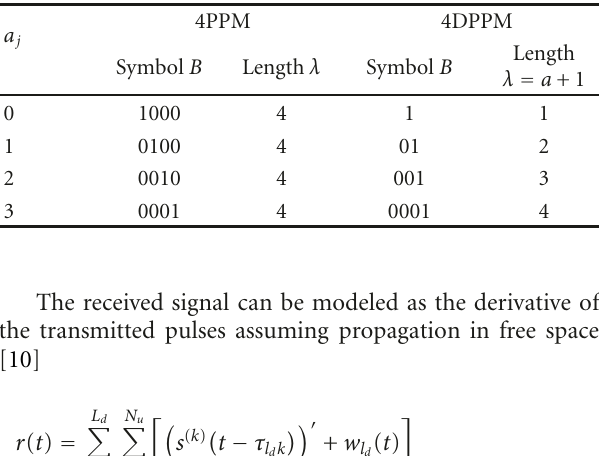
Table 1: Comparison of Symbol Mapping for 4PPM and